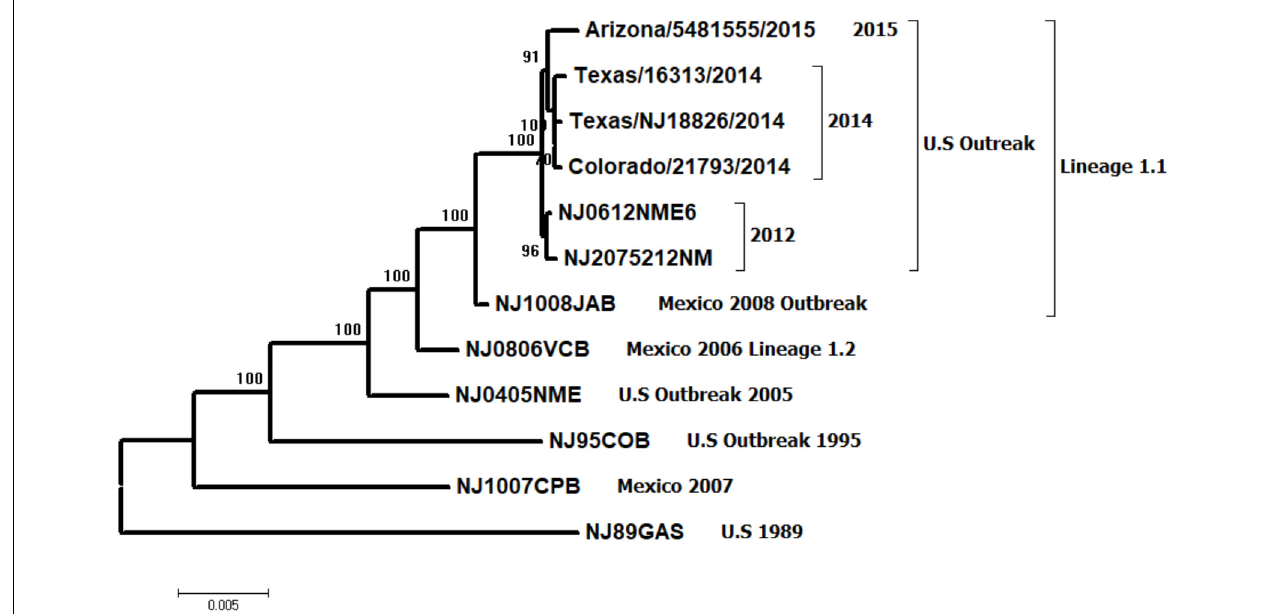
FIGURE 1 | Maximum likelihood phylogenetic analysis of 13 VSNJV from Mexico and the United States, collected between 1989 and 2015 based on the P protein hypervariable region. Notice the relationship between the emergent lineage 1.1 and its closest endemic relative, lineage 1.2 (represented by viral strain NJ0806VCB). These viruses are distinct from previously characterized viral strains isolated during earlier outbreaks in the United States (1995 and 2005) and a viral strain collected in an endemic zone of Mexico during 2007. Numbers above the interior nodes represent bootstrap values obtained after 1,000